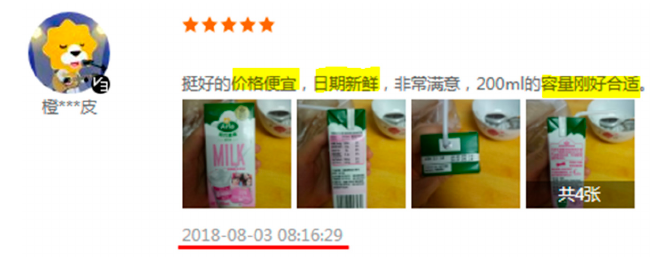
Figure 1. Online commodity evaluation.